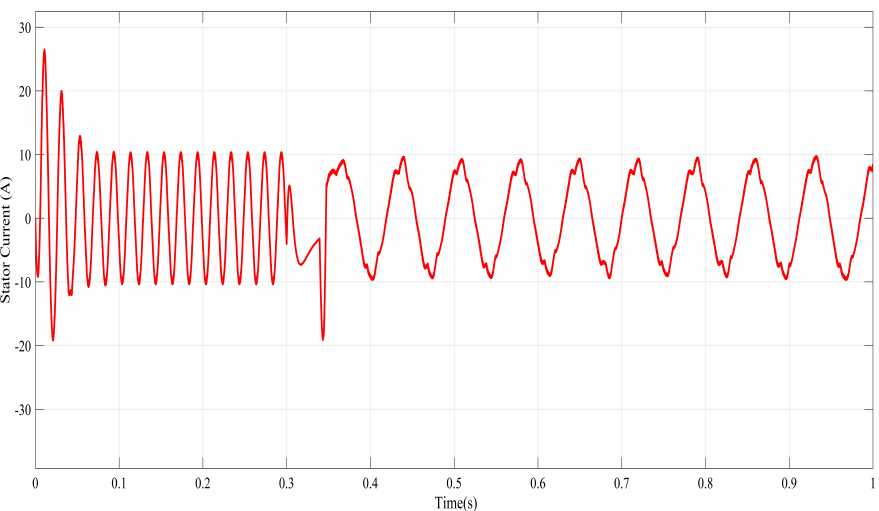
Figure 11. Stator current response to varying load